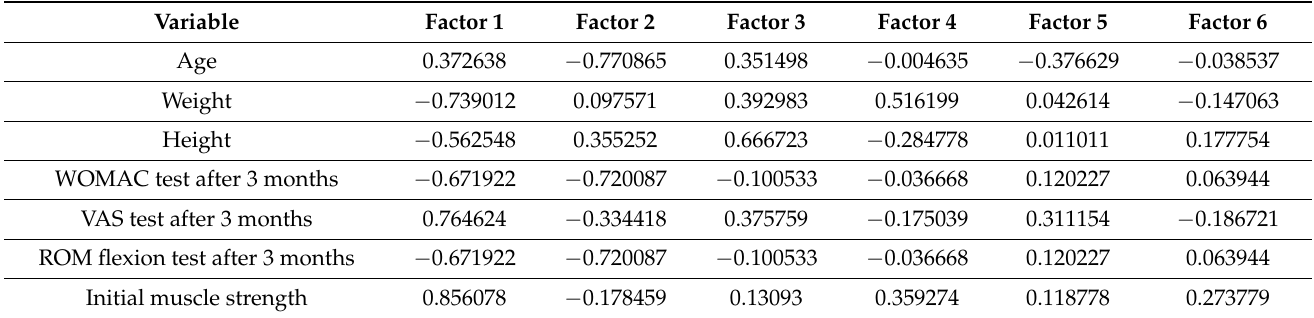
Table 11. Factor coordinates of the variables based on correlations for the control group (CG) after 3 months.